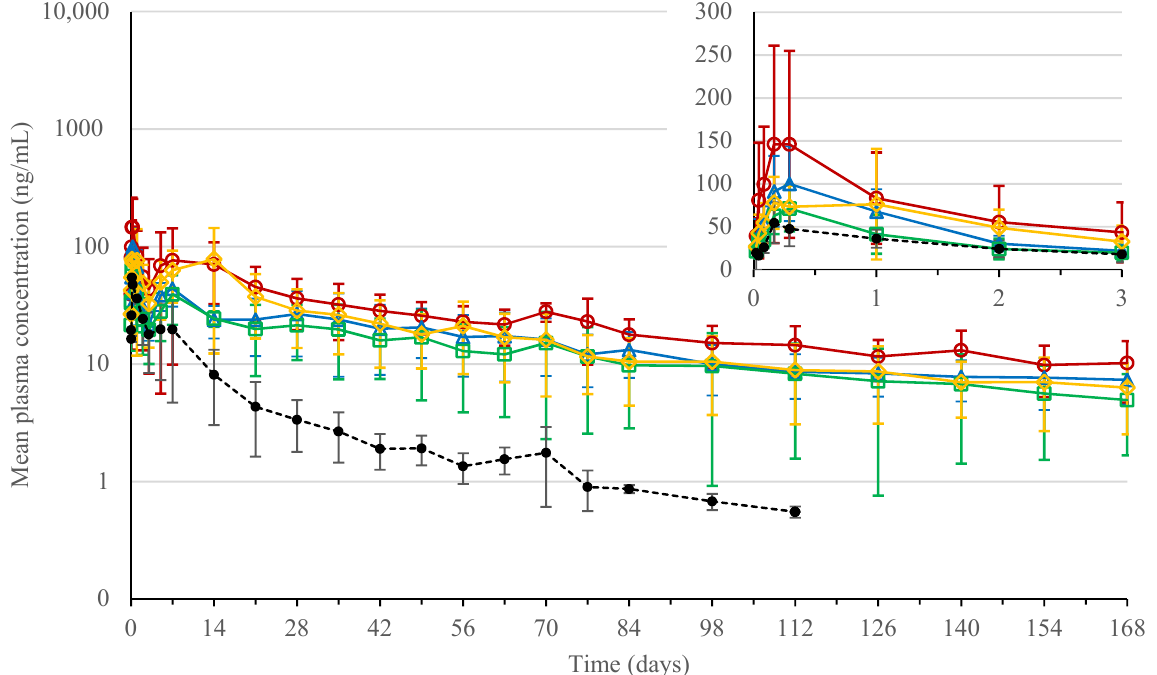
Figure 7. Plasma concentration-time profiles for bedaquiline in rat (mean profiles and standard deviation error bars for n = 3). Red circle: in situ forming gel (ISG) formulation 1 (200 mg eq./g bedaquiline fumarate salt in PLGA5050A/NMP 20/80% ( w / w )) dosed subcutaneously (SC) at 80 mg eq./kg; blue triangle: ISG formulation 2 (200 mg eq./g bedaquiline fumarate salt in PLGA7525A/NMP 20/80% ( w / w )) dosed SC at 80 mg eq./kg; green square: ISG formulation 3 (200 mg eq./g bedaquiline fumarate salt in PLGA7525E/NMP 20/80% ( w / w )) dosed SC at 80 mg eq./kg; orange diamond: ISG formulation 4 (200 mg eq./g bedaquiline fumarate salt in PDLLA/NMP 20/80% ( w / w )) dosed SC at 80 mg eq./kg; black dot: solution formulation 5 (5 mg eq./mL bedaquiline fumarate salt in PEG400/water 50/50% ( v / v )) dosed SC at 4 mg eq./kg. Table 3. Pharmacokinetic parameters in rat following subcutaneous administration of formulations 1 to 5. Analyte